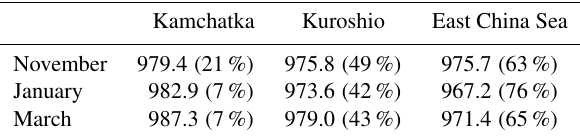
Table 4. Mean minimum sea level pressure of surface cyclones passing through the northern target region according to genesis re- gions and, in parenthesis, the fraction of cyclones satisfying the criterion for “bomb cyclogenesis” (deepening larger than 24hPa within 24h normalized to 60 ◦